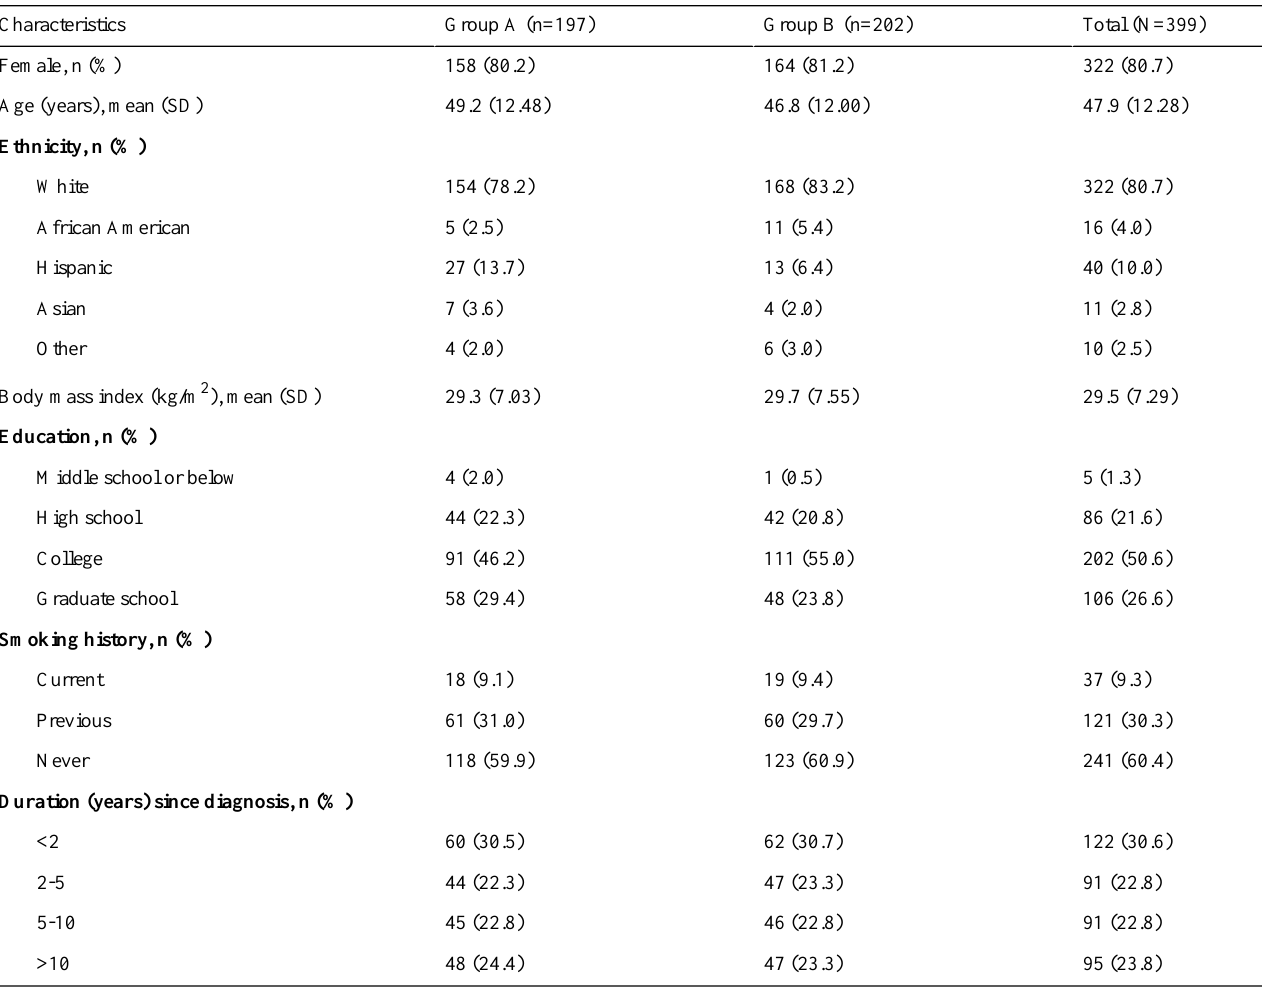
Table 1. Demographics and baseline clinical